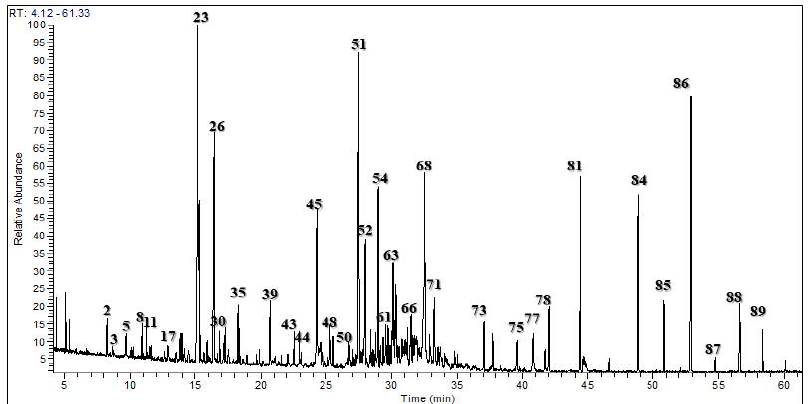
Figure 2. Gas Liquid Chromatography (GLC) profile of the volatile constituents in the essential oil of C. morifolium flower heads.